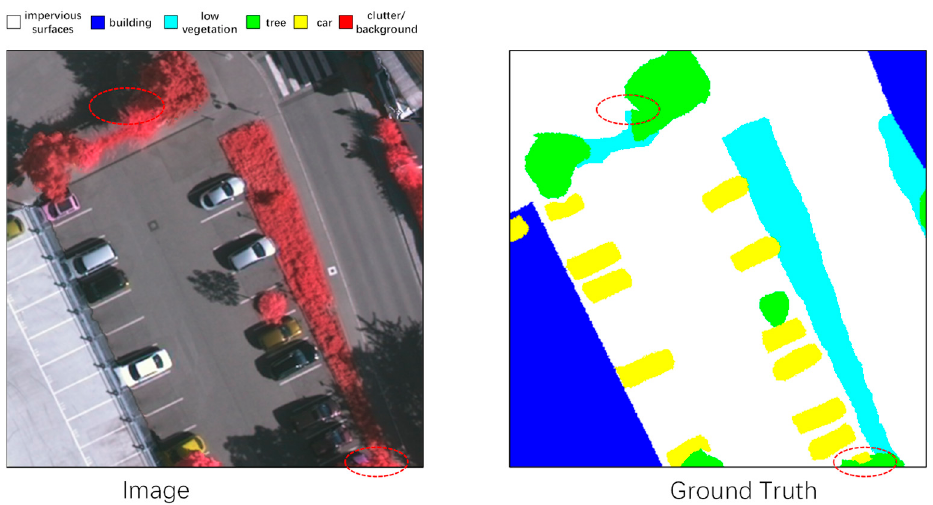
Figure 1. A high-resolution remote sensing sample image and the corresponding ground truth from the ISPRS Vaihingen dataset. The red circle shows the irregularity of the target boundary in the remote sensing images